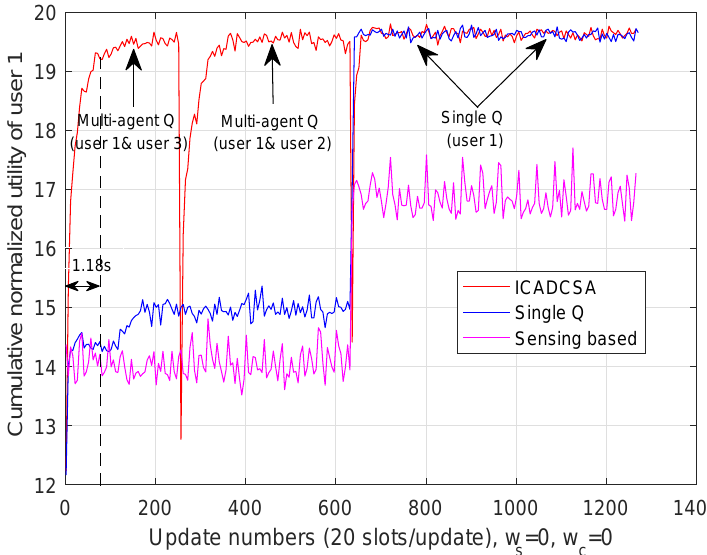
Figure 8. Cumulative normalized utility of User 1. ICADCSA, interference-aware cooperative anti-jamming distributed channel selection algorithm.